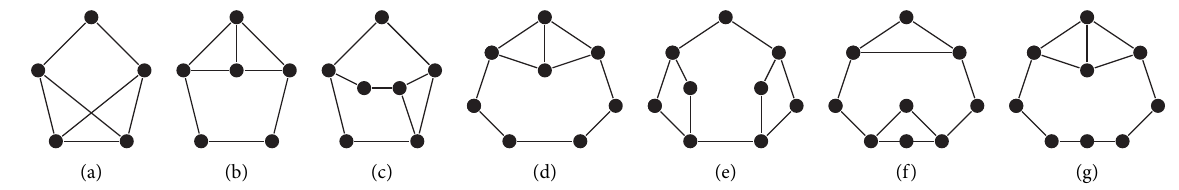
Figure 11: Tricyclic graphs with minimum edge Mostar index of order n , 5 ≤ n ≤ 9. (a) G